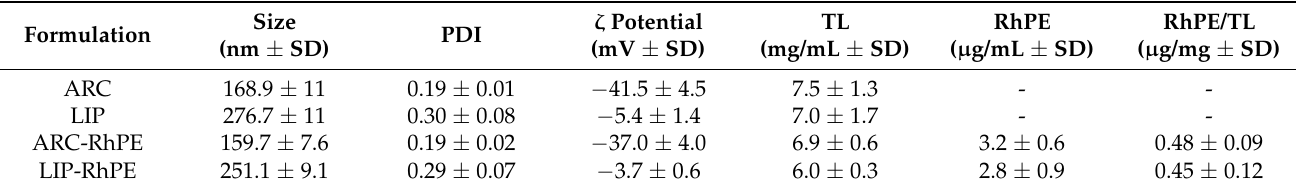
Table 1. Physicochemical characteristics of